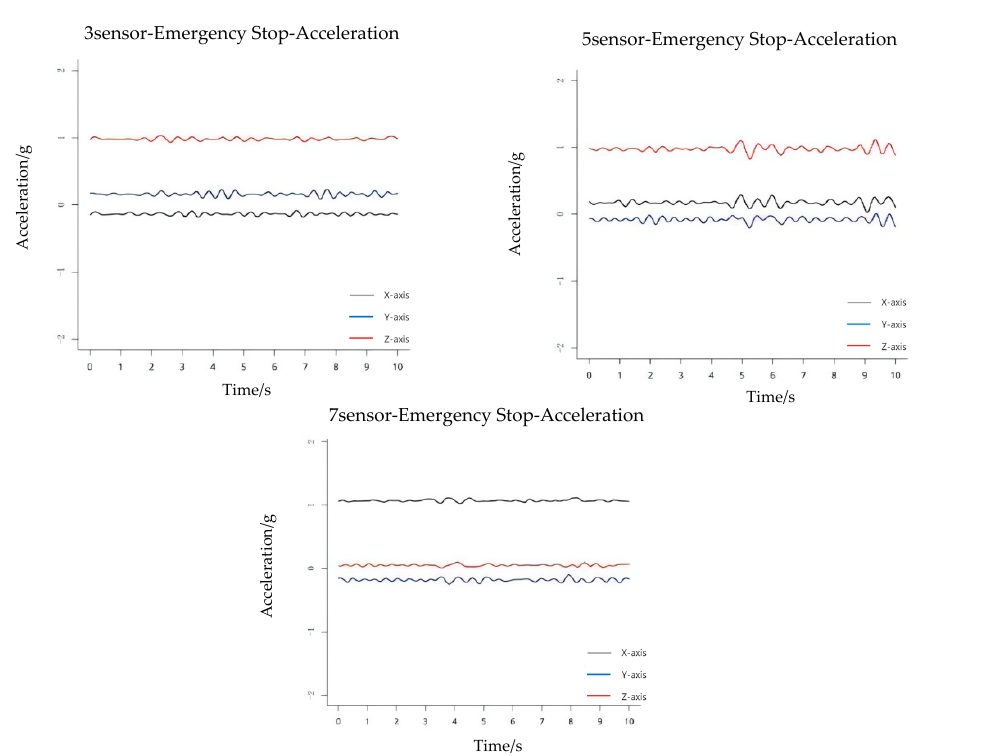
Figure 5. Acceleration graph at the sudden stop.